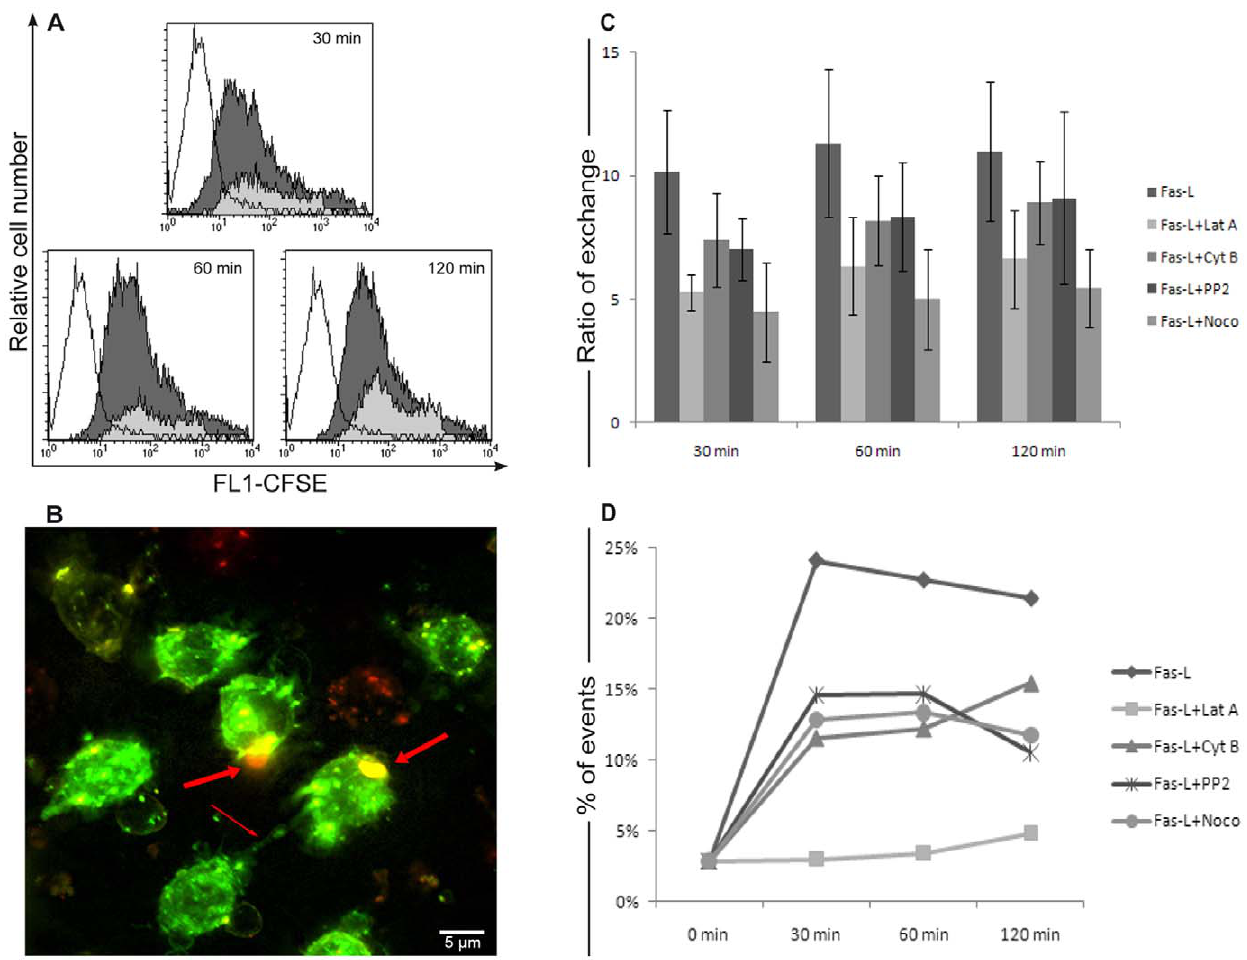
Figure 3. Cytoplasmic transfer evaluation by CFSE stain. Data are presented as an overlay of three different cytometric histograms (A). Empty histograms represent untreated cells at the outset. Grey and light grey histograms are generated using R1 and R2 gates (see Fig. 1) and therefore represent isolated and conjugated cells, respectively. The results show that MFI is higher in R2 gated events if compared to R1 gated events for each time points. CD4 + T cells staining with CFSE and DiI after 30 min of FasL treatment were analyzed by fluorescence deconvolution microscopy (B). The image shows a nanotube connecting two cells (thin arrow) and the uptake of red patches by green cells (thick arrows). Time-course of CFSE exchange (C) was evaluated for the indicated times of FasL treatment with different pharmacological agents, Lat A (Latrunculin A), Cyto B (Cytochalasin B), PP2 and Noco (Nocodazole). In particular, it is possible to observe a significant CFSE uptake from red cells, which was strongly inhibited by Lat A and Noco. Results from n=6 separate experiments showed statistically significant differences for all inhibitors (p , 0.05). Percentage of cell conjugates (D) was compared among all experimental conditions (FasL vs specific inhibitors). Statistical analyses of inhibitors effect on CFSE exchange (C) and cell conjugates formation (D) highlight a different behaviour of Lat A and Noco. Lat A treatment led a strong decrease of both phenomenon, whereas Noco treatment affected majorly cytoplasmic material transfer.